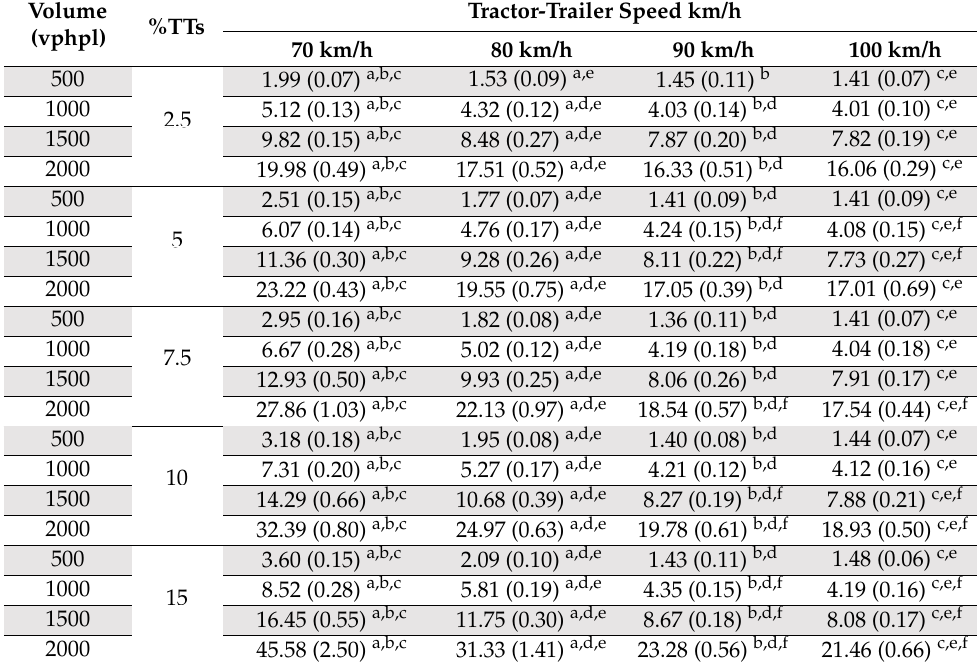
Table 4. Delay results for speed limit of 100 km/h.